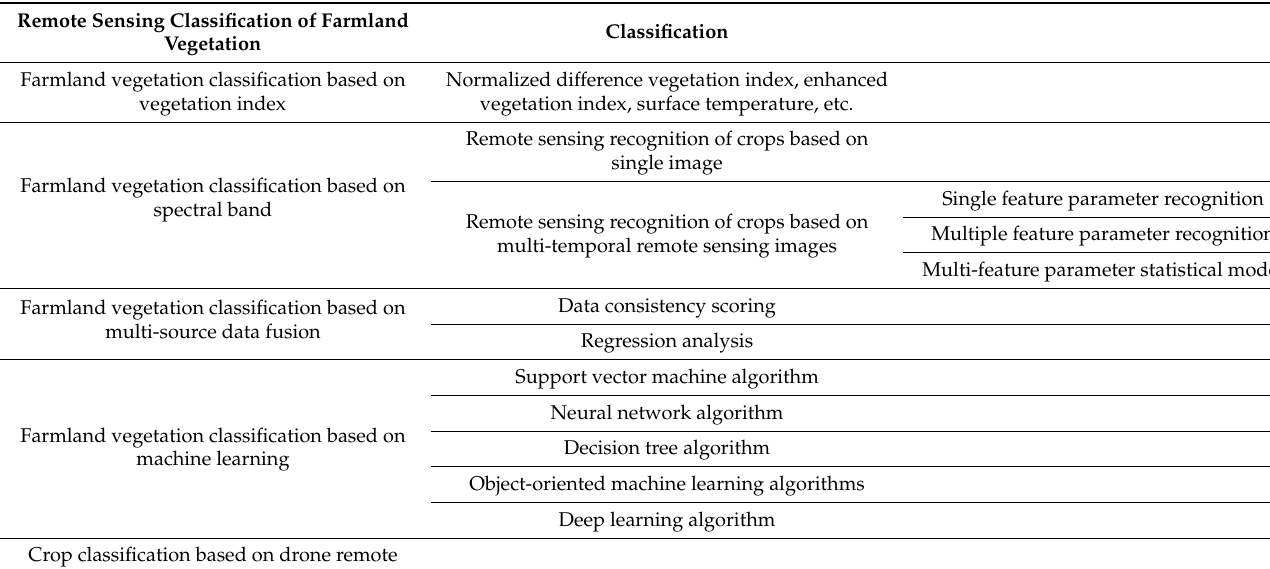
Crop classification based on drone remote